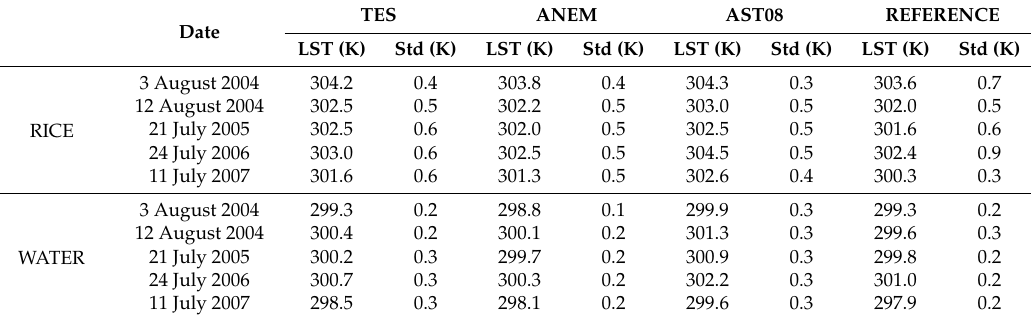
Table 7. LST values retrieved at evaluation points of rice crops and water from TES, Adjusted Normalized Emissivity Method (ANEM) and AST08 scenes, together with reference values measured at the ground for each analyzed day. The standard deviation (Std) of each measurement is also